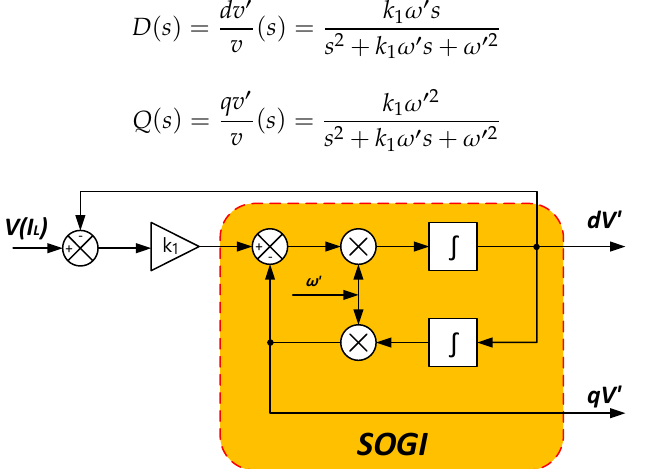
Figure 8. Block diagram of second order generalized integrator (SOGI).